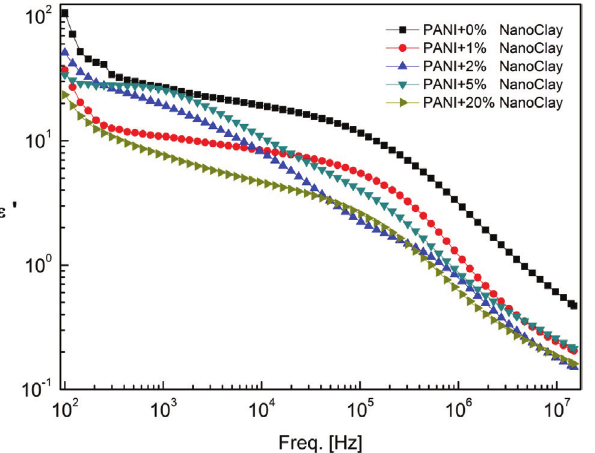
Fig. 5: Frequency dependency of the dissipation factor of PANI +